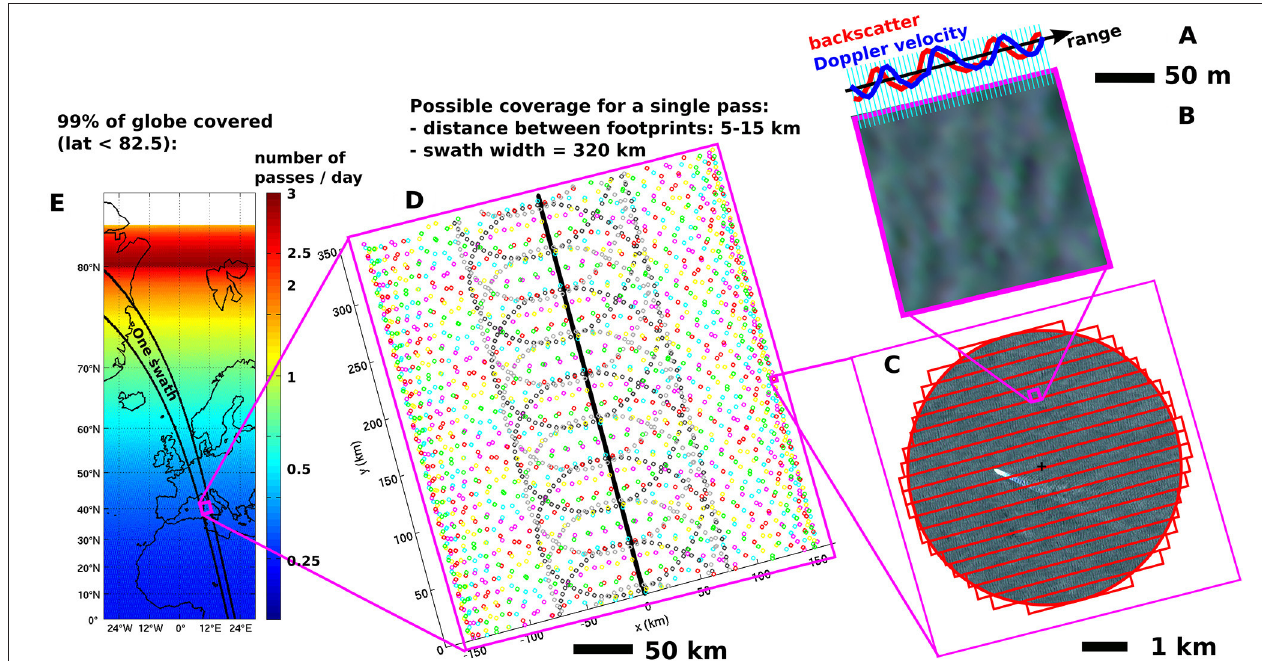
FIGURE 2 | Spatial scales covered in the SKIM measurement, from (A) the range-resolved Doppler velocity and back-scatter power that correspond to 2,048 range gates at 0.7 m resolution (cyan lines). The data in (A) corresponds to an average over the azimuthal direction, perpendicular to the range direction. The averaged features include the wind-generated waves that appear in (B) , as resolved in a Sentinel-2 image. These measurements are made within footprints such as shown in (C) that have a diameter of 6 km. Yet, different azimutal “strips” with 300-m resolution can be separated (red boxes in C ). The footprints are sparsely distributed across a 320-km wide swath shown in (D) . These footprints are obtained by the rotation of beams on the SKIM radar, with 3 beams looking at 12 ◦ incidence in color, 2 beams at 6 ◦ in gray, and one beam at nadir in black. The 824 km altitude orbit considered today gives an average revisit time between 8 h and 4 days shown in (E)